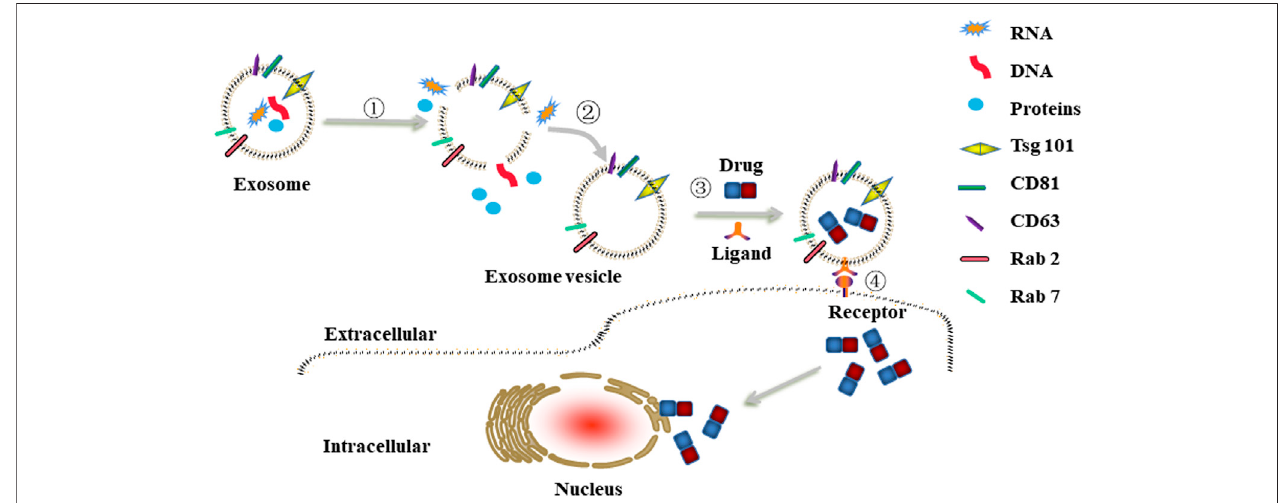
FIGURE 5 | Schematic illustrations of engineered exosomes as drug carriers. ① - ② The removal procedure of natural contents in cells-derived exosomes to construct exosome vesicle. ③ Exosome vesicle was modi fi ed with targeting moieties (e.g., folic acid, hyaluronan) via co-incubation and then loaded with anti-cancer drugs (e.g., DOX, PTX, 5-Fu) via electroporation or sonication to obtain engineered exosomes. ④ The engineered exosomes were internalized by cancer cells through ligand/receptor interaction.